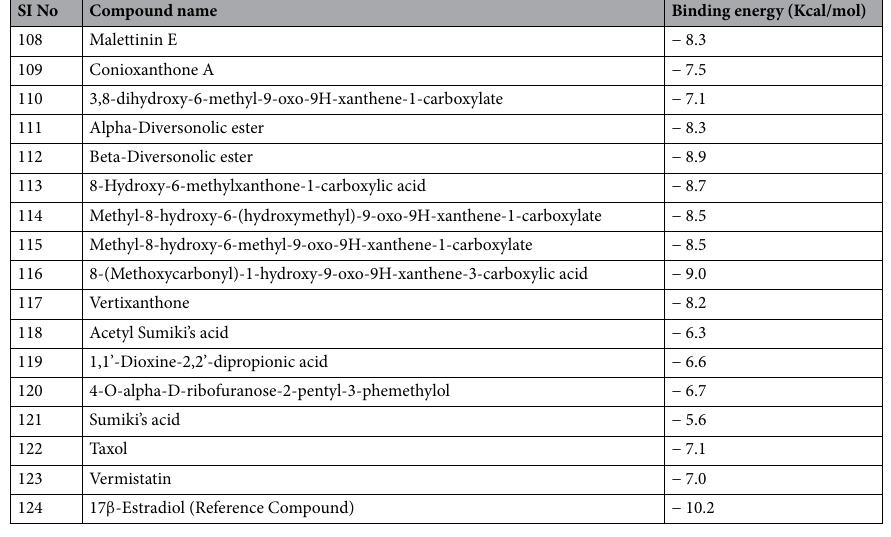
Table 1. Molecular docking results of the bioactive compounds extracted from Cladosporium spp. against estrogen receptor alpha (PDB: 6CBZ)